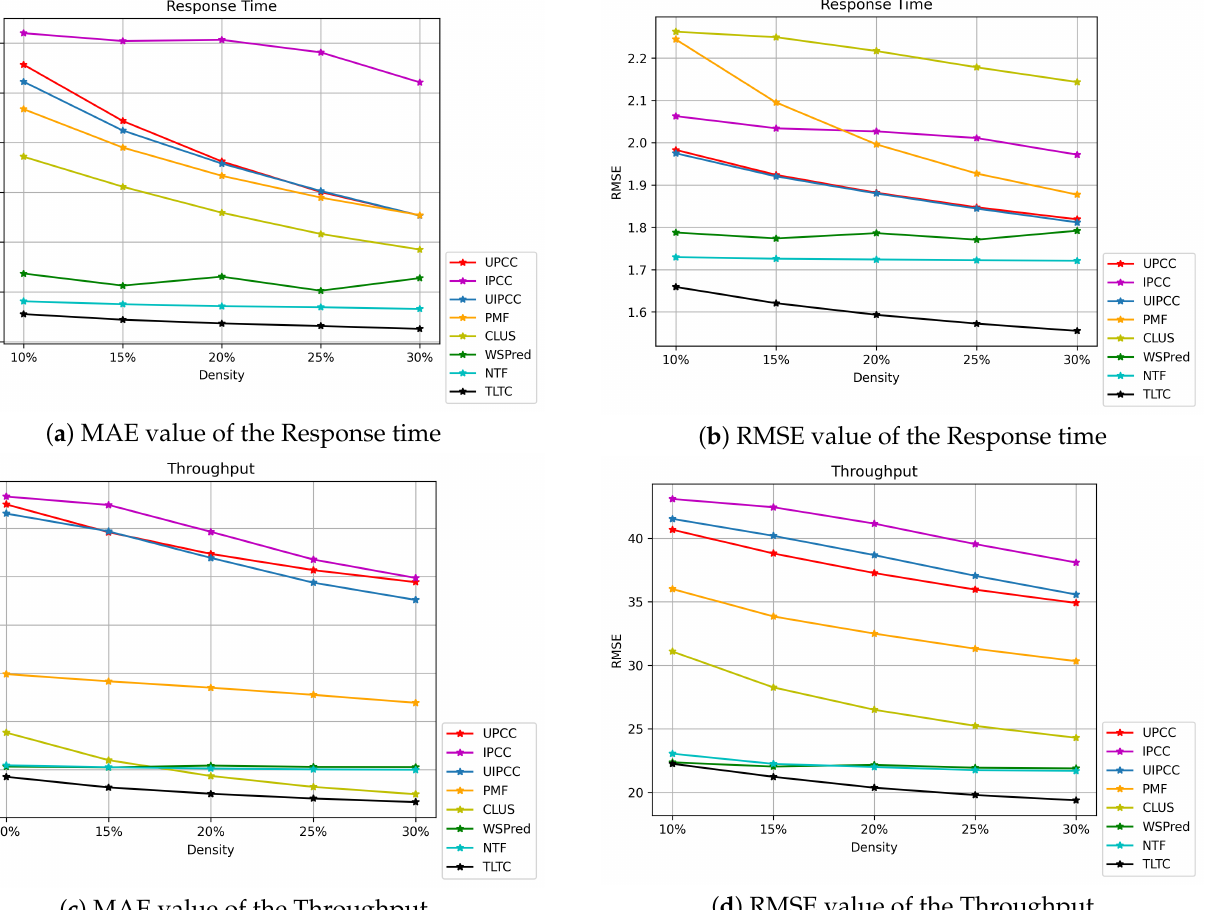
Figure 6. Comparison of QoS prediction accuracy based on MAE and